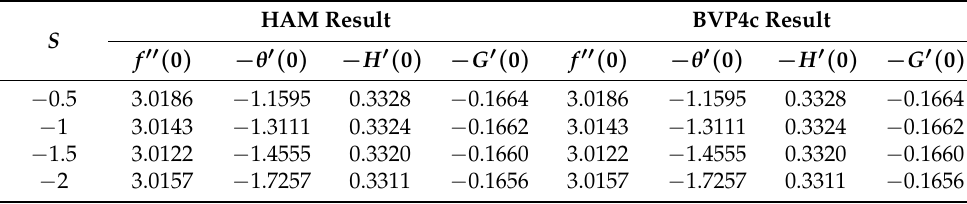
Table 4. Computational for f (cid:48)(cid:48) ( 0 ) , − θ (cid:48) ( 0 ) , − H (cid:48) ( 0 ) and − G (cid:48) ( 0 ) with P r = R = Sc = K 1 = K 2 = Ha = 0.5, L = δ = 2, Q = 4 and differing values of S